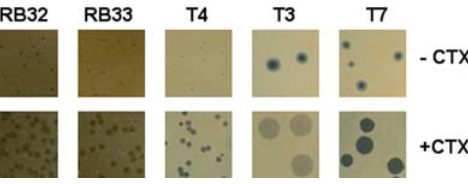
Figure 4. Plaque sizes of various coliphages with and without cefotaxime (CTX) in Luria agar plates. Phages RB32 and RB33 were grown on E. coli strain MFP (50 ng/mL CTX) at 37 u C; and T4, T3 and T7 were grown on E. coli strain AS19 (30 ng/mL CTX) at 25 u C. All plaques were photographed at identical magnifications.